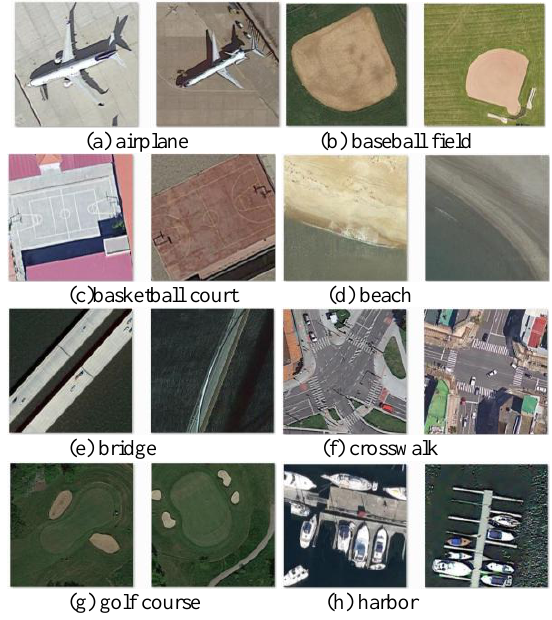
Figure 10. some example images from the V-RSIR dataset Figure 11 represents the spatial distribution of the V-RSIR dataset. The images in this dataset are mainly distributed in North America, Europe and South America.